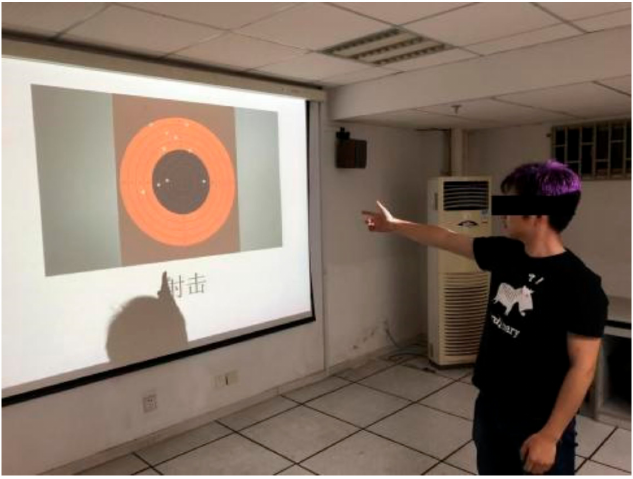
Figure 2. Experimental